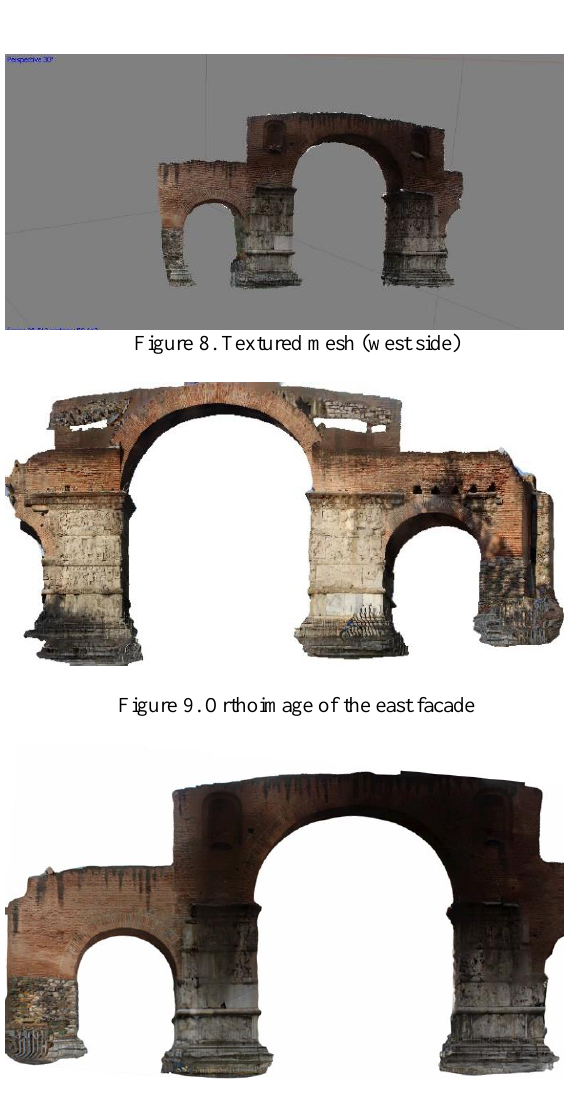
Figure 10. Orthoimage of the west